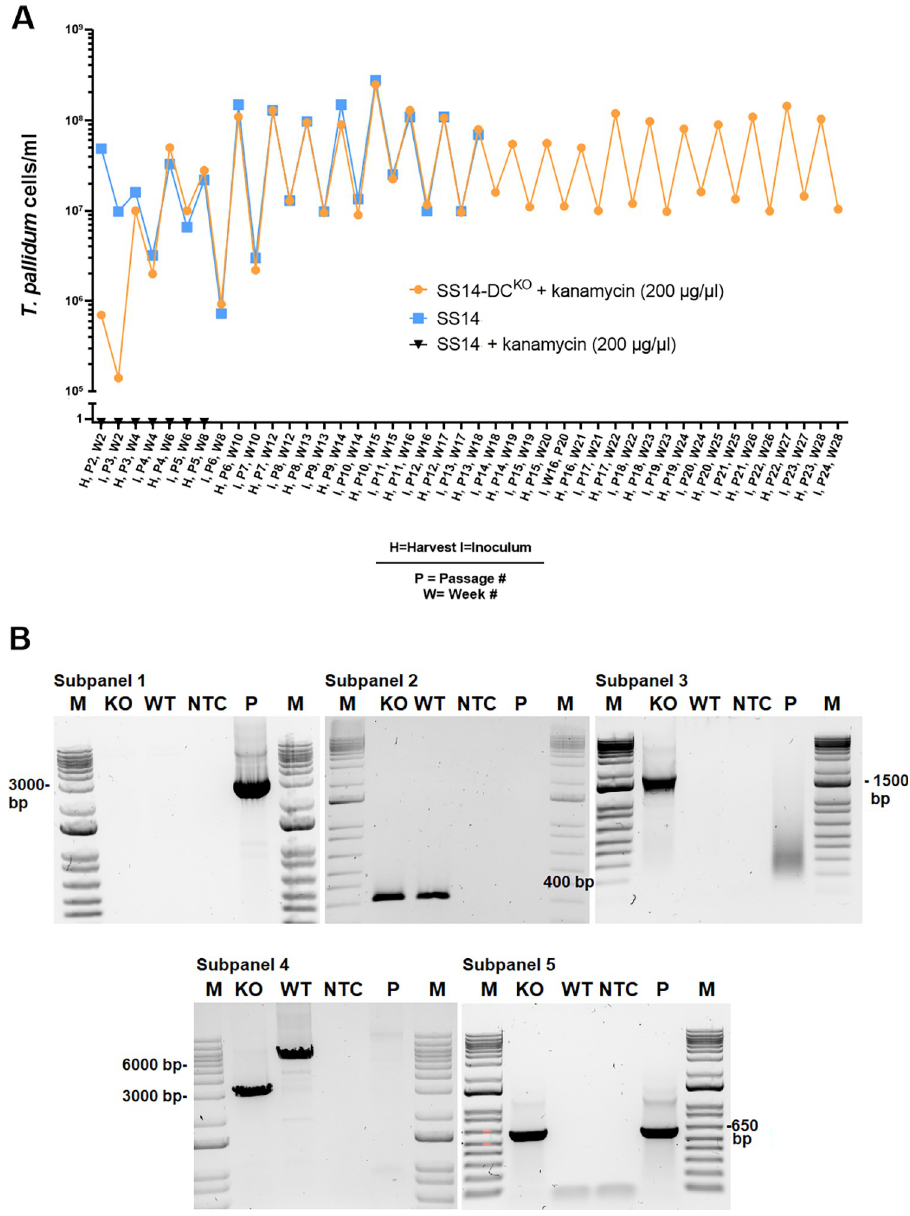
Fig 2. In vitro growth curves of the strains used here and molecular assessment of integration of the kan R cassette. ( A ) Twenty-eight-week in vitro growth curve of transformed SS14 T . pallidum cells (SS14-DC KO ) in selective media (solid orange circles), WT SS14 cells in selective media (solid black triangles), and WT SS14 strain in non-selective media (solid blue squares). Propagation of the parent strain for this experiment stopped at week 18. Parent treponemes propagated in kanamycin-containing media were never countable by DFM. ( B; subpanels 1–5 ) Qualitative amplifications to assess kan R integration. Primer combinations are reported in Table 1. Subpanels show amplifications a) with vector-specific primers (subpanel #1, 2,967 bp amplicon), yielding an amplicon only with suicide vector control DNA; b) with tp0574 primers (subpanel #2, 313 bp amplicon), positive in both parent and transformed treponemes; c) with primers annealing to the kan R gene and outside of the right homology arm in the T . pallidum genome (subpanels #3; 1,846 bp size amplicon), yielding a positive amplicon only with template from transformed treponemes; d) with primers annealing upstream and downstream of the homology arms in the T . pallidum genome (subpanel #4, 2,982 bp and 5,980 bp size amplicons), yielding a shorter amplicon size in transformed treponemes due to deletion of the DCs); and primers annealing to the kan R gene (subpanel #5, 663 bp size amplicon). M: molecular size marker (bp); KO: SS14-DC KO , WT: parent WT SS14; NTC: No-template control, P: suicide vector (p DC arms-47p- kan R ) plasmid DNA.